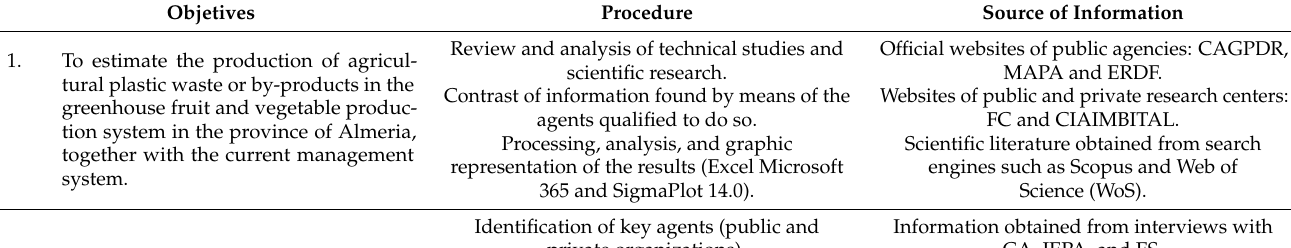
Table 1. Specific methodology and sources of information